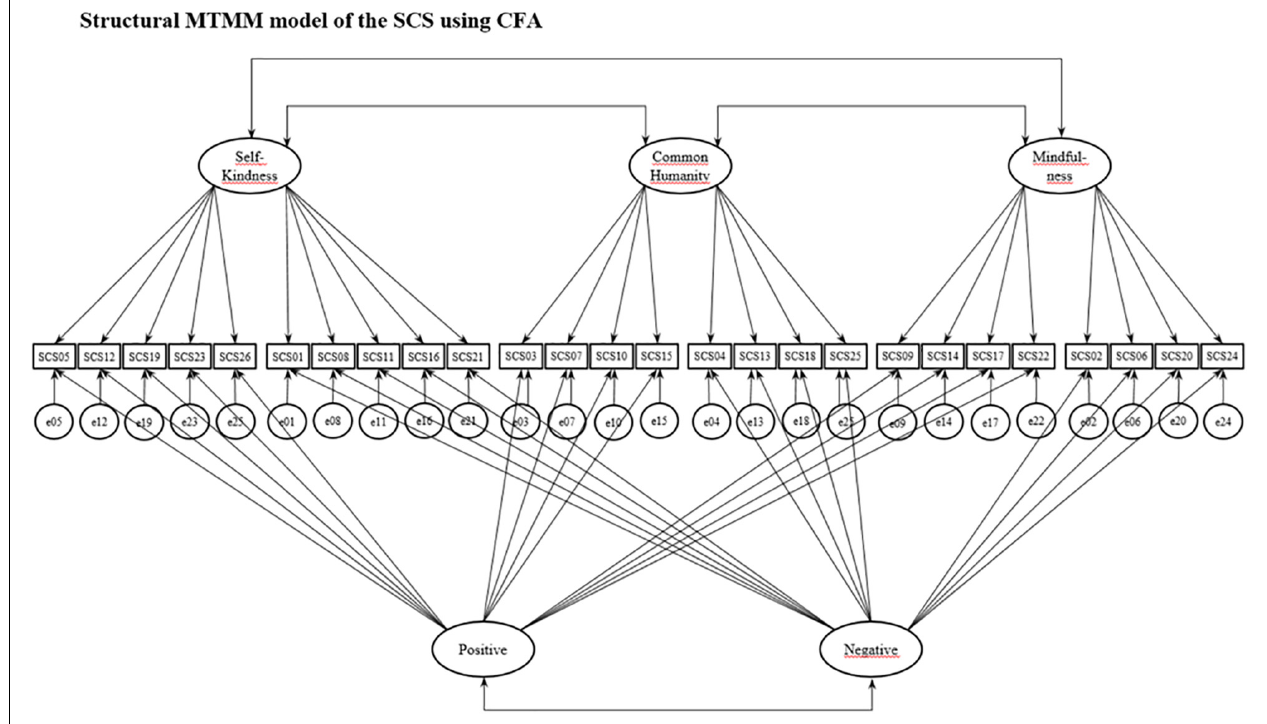
FIGURE 1 | Structural MTMM model of the SCS using CFA. The circles represent latent components, and the rectangles are observable variables (SCS items). One-way arrows represent factor loadings, and two-way arrows are